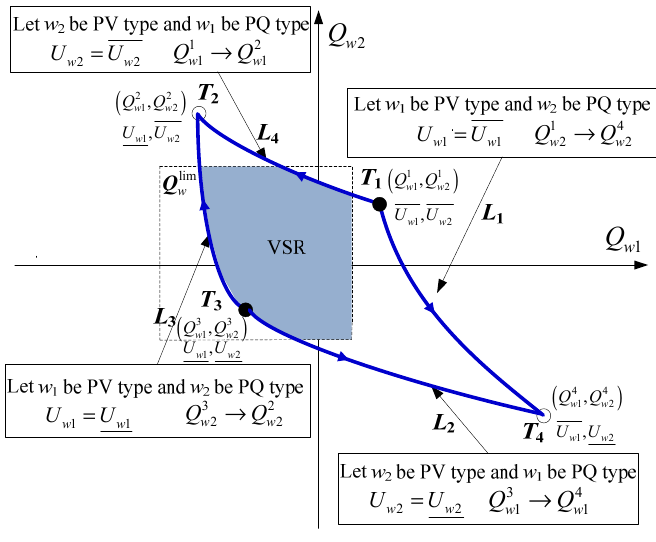
Figure 3. Security region for an example with two wind